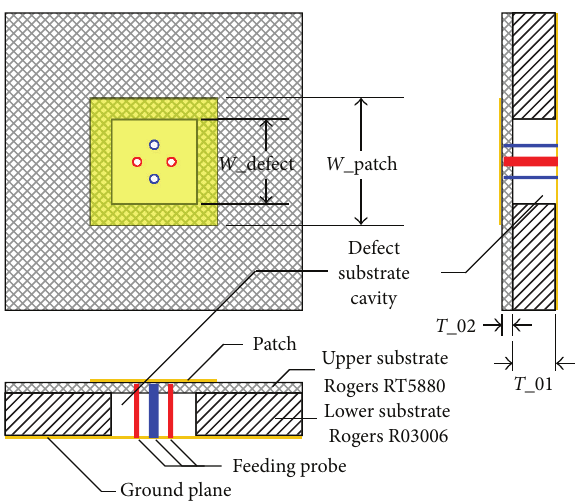
Figure 4: Sectional view of defect substrate patch